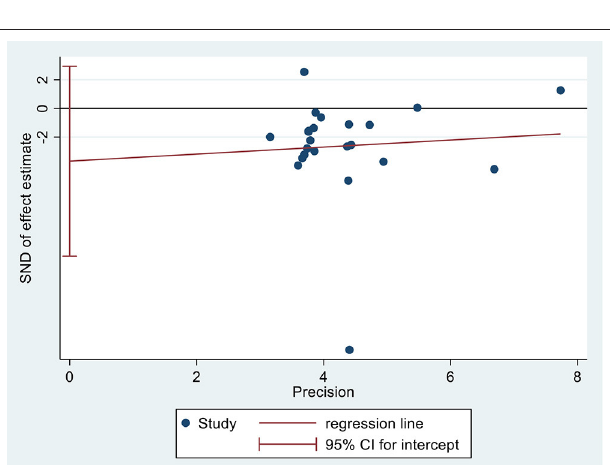
FIGURE 7 | Publication bias test based on HAMD. HAMD, Hamilton Depression